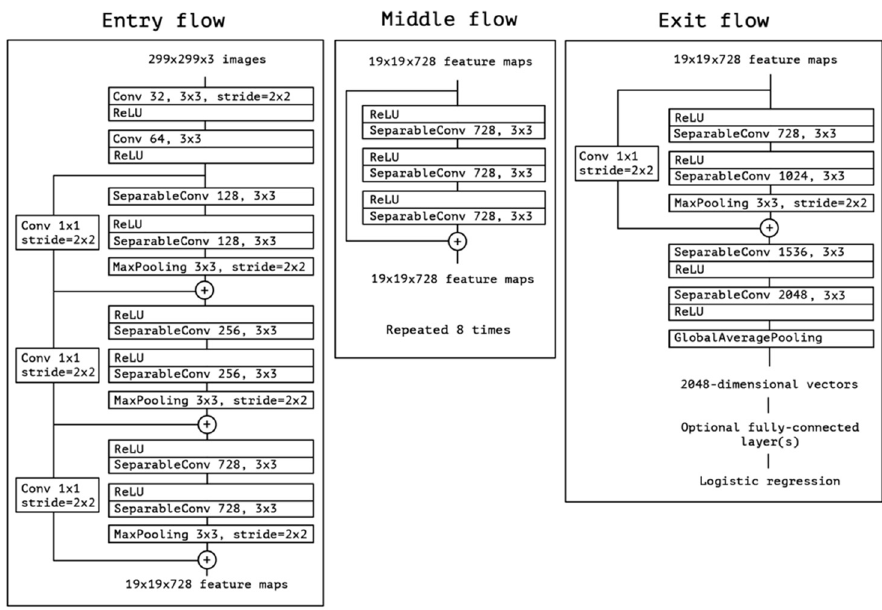
Figure 3. The Xception Network architecture. Reprinted with permission from ref. [22]. Copyright © 2017, IEEE.